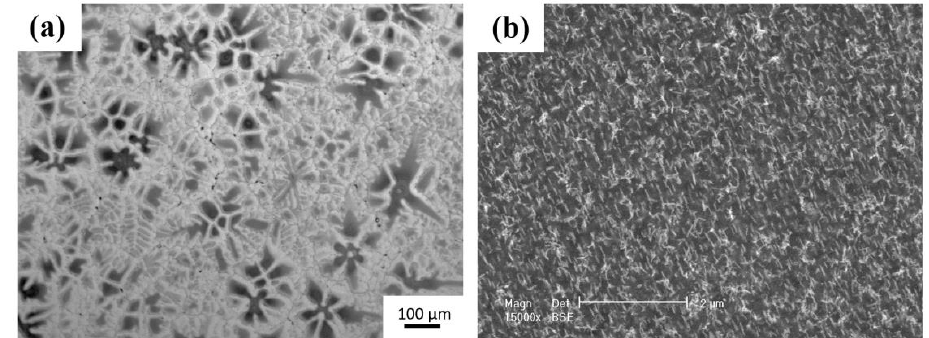
Figure 3. ( a ) Metallograph and ( b ) SEM image of cast ZK60 Mg alloy.